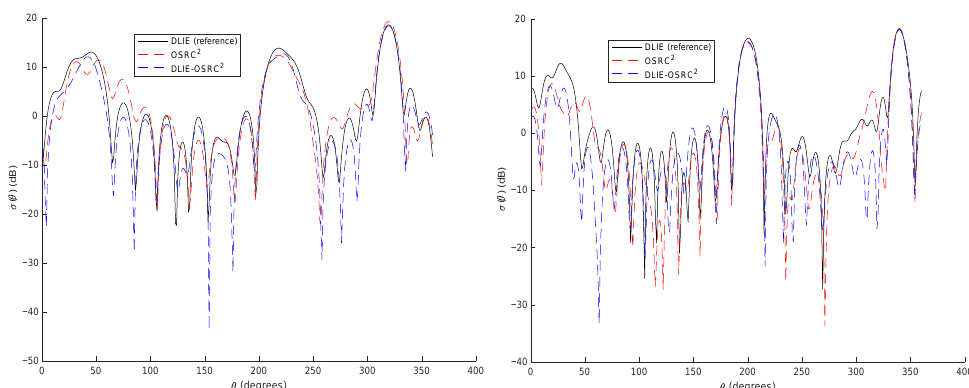
Figure 3. Bistatic SCS for the unit square cylinder with cavity and Neumann boundary